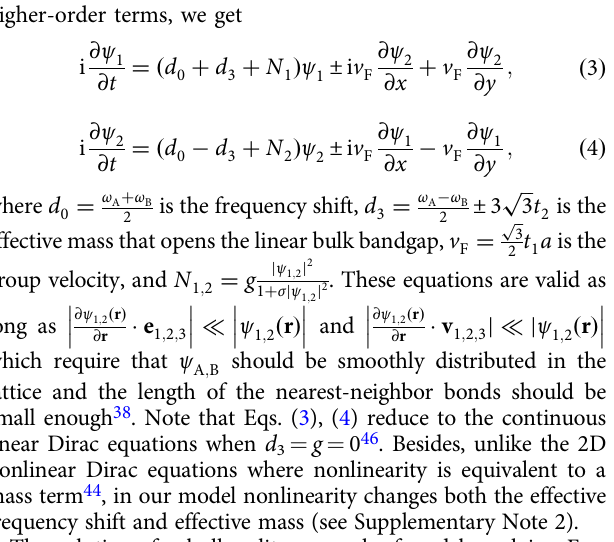
Fig. 2 Bulk solitons under the self-focusing nonlinearity with g = 1. a , b The amplitudes of the two pseudospin components ψ valley. c , d The amplitudes of the two pseudospin components of the bulk soliton at K ′ valley. The color bars in a – d denote the amplitudes and the insets in a – d are the phases. The frequencies of the bulk solitons are ω =